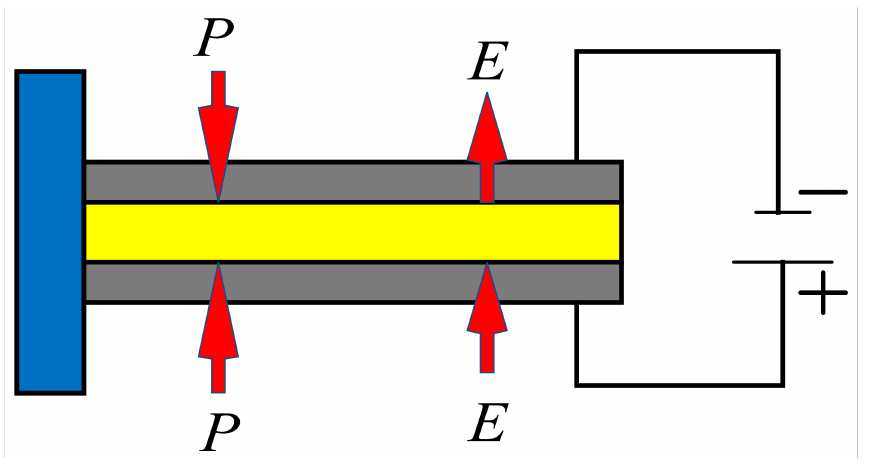
Figure 9. Transverse mode energy